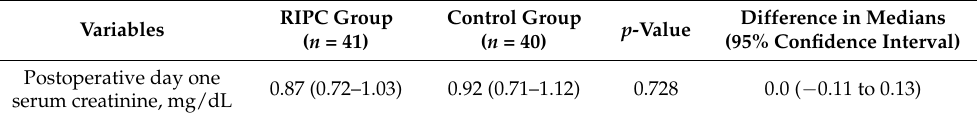
Table 2. Comparison of the secondary clinical outcomes between the RIPC and control